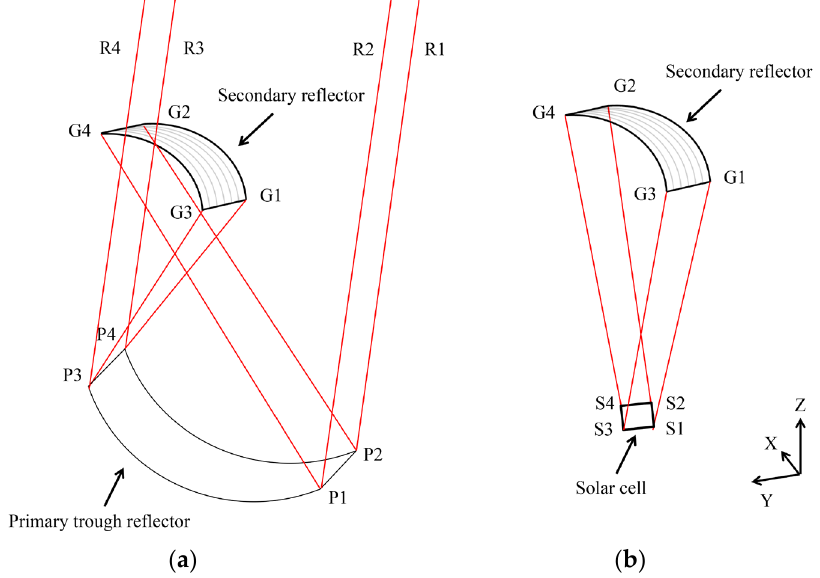
Figure 6. Edge-ray principle showing incident rays reflected from edges of the reflectors towards the receiver: ( a ) first-stage concentration (primary reflector to secondary reflector) and ( b ) second-stage concentrator (secondary reflector to the receiver).